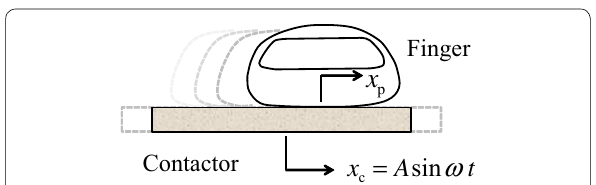
Fig. 1 Finger sliding over laterally vibrating contactor